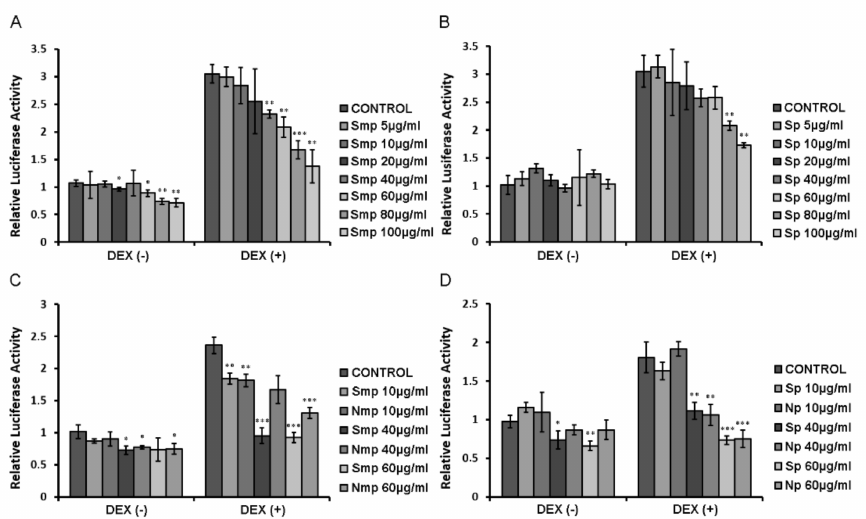
Figure 2. Suppression of the DEX-induced GR transcriptional activation by South ( A , B ) and South versus North ( C , D ) Chios mastiha tree leaves fractions. Luciferase and β -galactosidase activity were assessed in cell extracts from HEK293 in hormone-free medium, transiently co-transfected with a Glucocorticoid Response Elements (GRE)-Luc reporter gene construct and a β -galactosidase reporter construct and subsequently treated with 5–100 µ g/mL of leaves fractions and/or 1 µ M DEX, for 6 h. Control cells were treated with DMSO (1:1000) and EtOH (1:1000). Relative luciferase activity was expressed as luciferase activity normalized against β -galactosidase activity. Data are expressed as the mean ± SD, ( n = 6–9), * p < 0.05; ** p < 0.01; *** p < 0.001, compared to relative